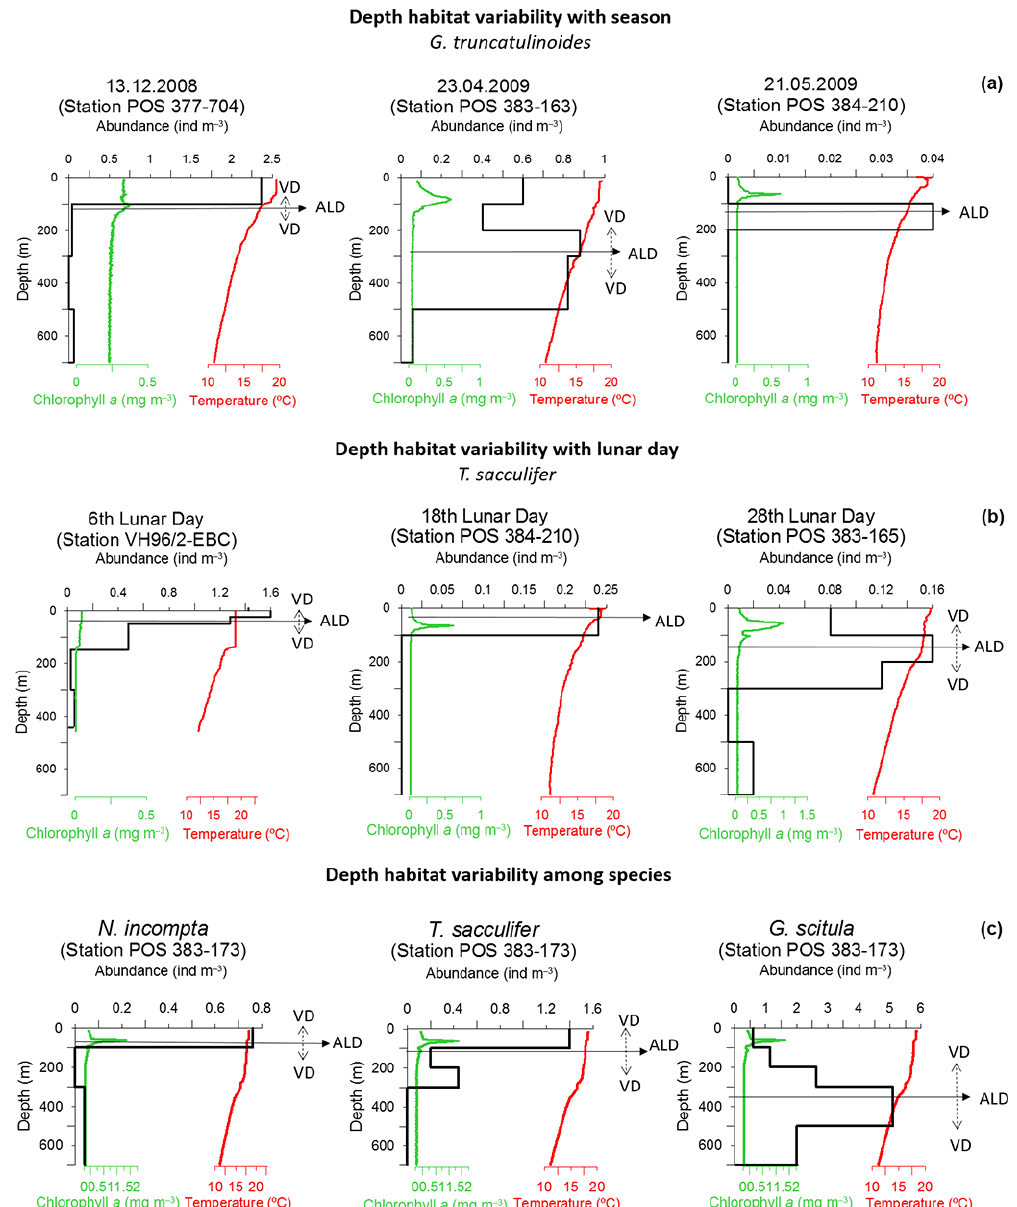
Figure 5. Examples of potential environmental parameters affecting vertical habitat of planktonic foraminifera in the studied region. (a) Ver- tical distribution of one species in the Azores region at different times of the year, showing apparent changes in ALD with season. Also plotted is the in situ temperature and chlorophyll a concentration (where available). (b) Vertical distribution of one species in the Azores region sampled at different times of the lunar cycle, showing apparent changes in ALD with lunar phase. (c) Vertical distribution of three species at the same station, showing different vertical